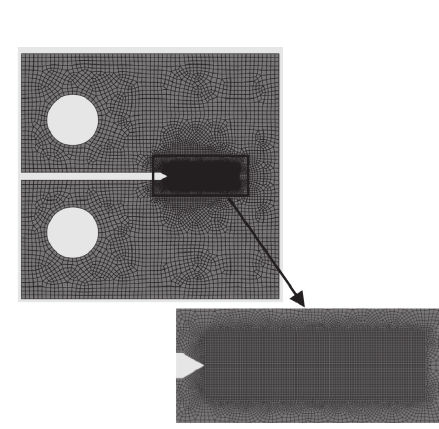
Figure 3: Global and local mesh of CT